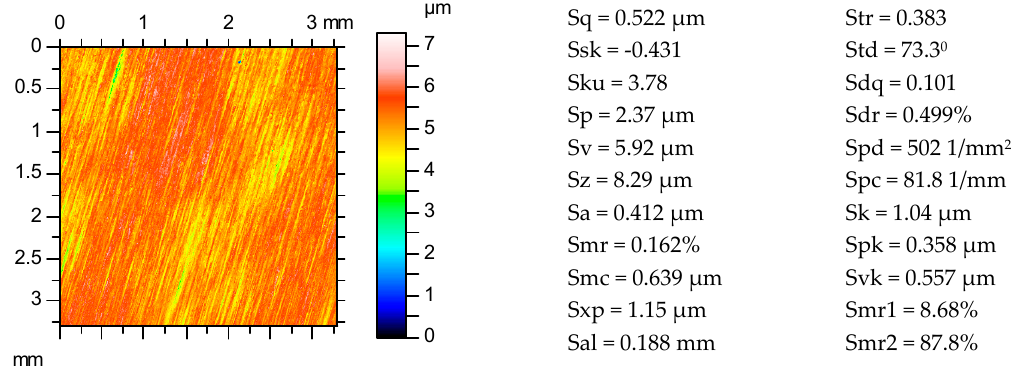
Figure 2. Contour plot of ground surface and its surface topography parameters.